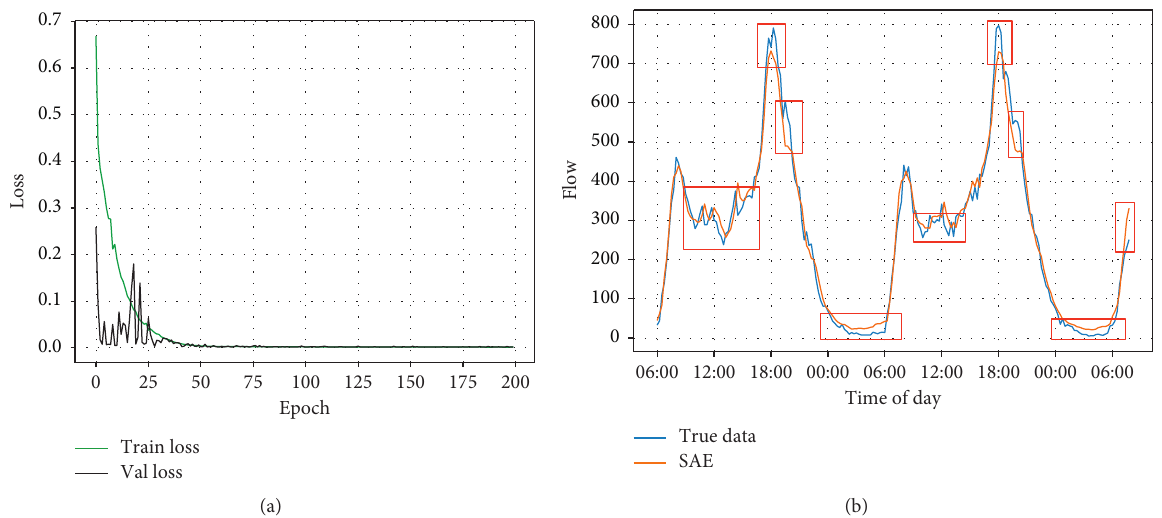
Figure 23: SAE training and prediction. (a) SAE loss function and (b) SAE prediction